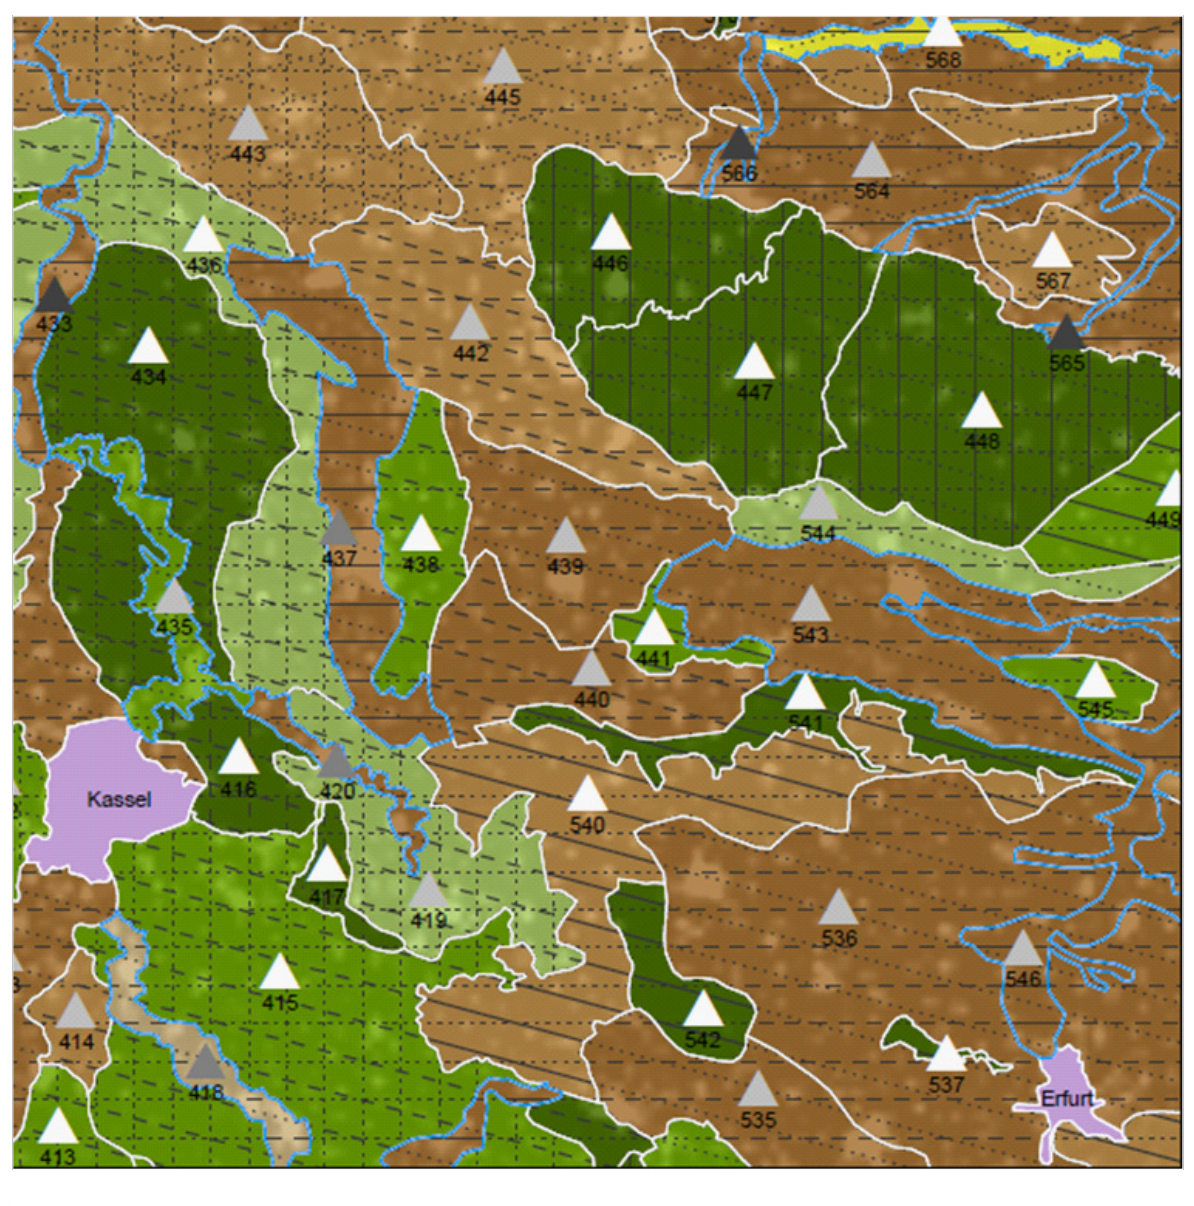
Figure 12: Map displaying the visual landscape characterof central Germany following J.G. Granö’s conception (Kirkamm, 2011; portion of 1:800 000